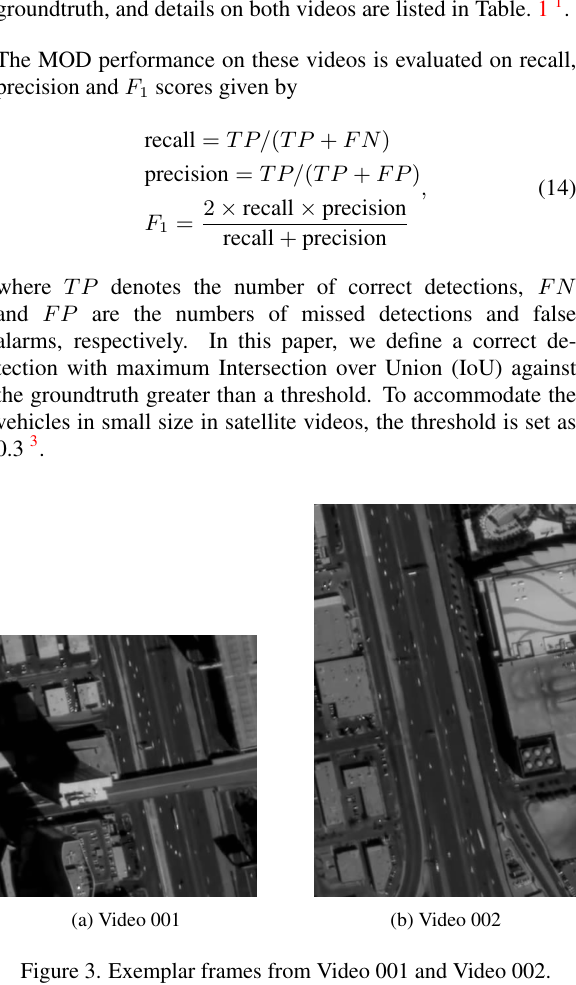
Figure 3. Exemplar frames from Video 001 and Video